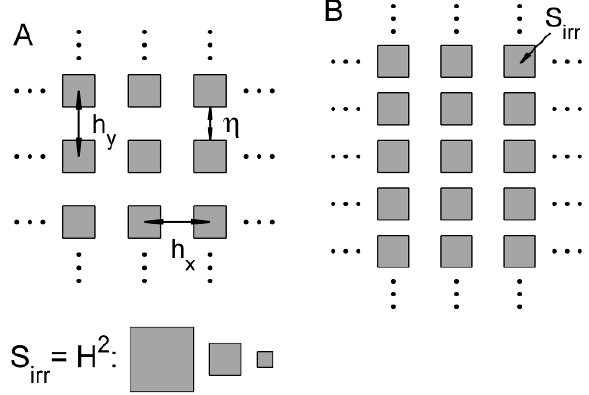
Figure 1. Two pattern schemes (Schemes ( A ) and ( B )) used to form domain structures. Patterns contain periodically arranged squares. Below, for clarity, the relationship between the areas of squares ( S irr ) whose side H takes values 1 μm, 0.5 μm, and 0.25 μm is presented. See also the text.